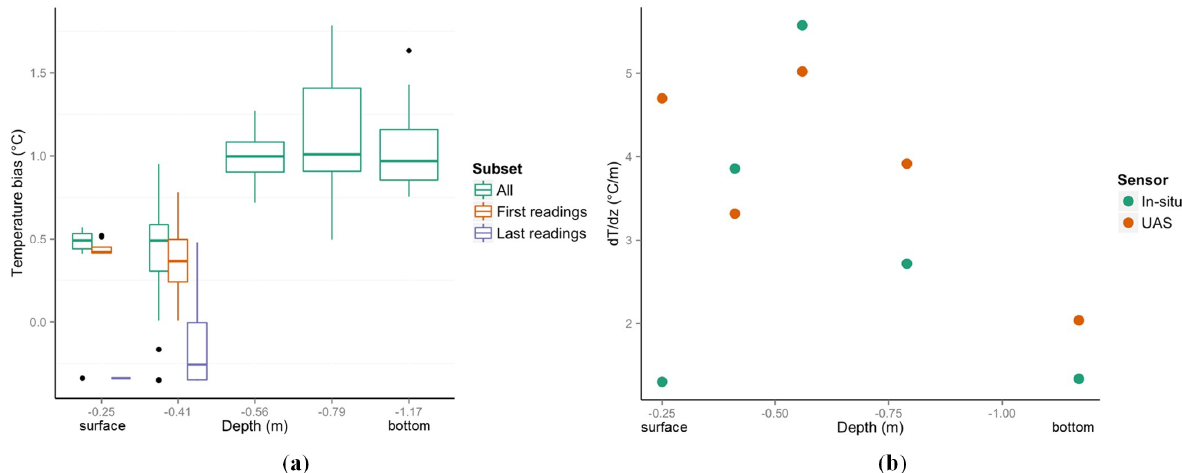
Figure 5. Comparison of UAS-borne and in situ temperature sensors, including logged data and detected thermal gradient. ( a ) Bias in temperature measured at each depth; ( b ) comparison of the derived temperature gradient at each